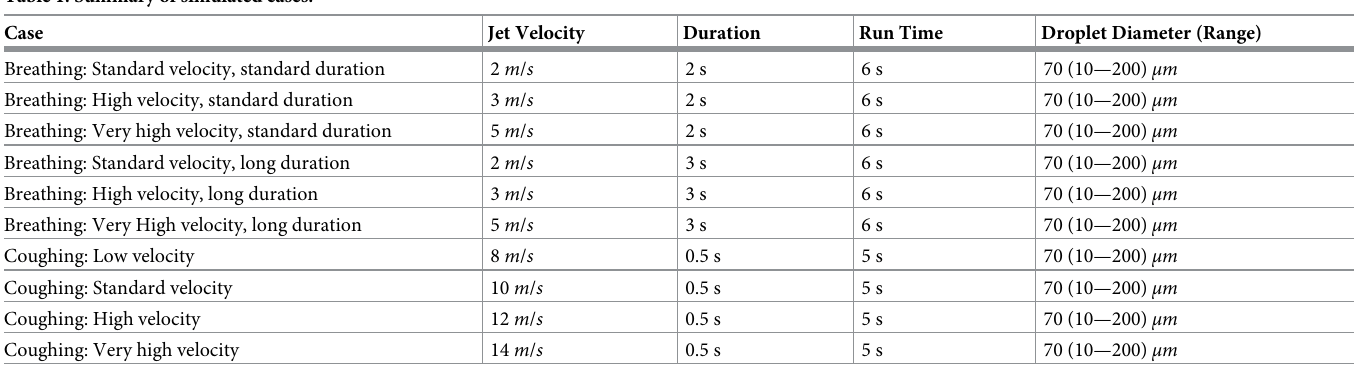
Table 1. Summary of simulated cases.